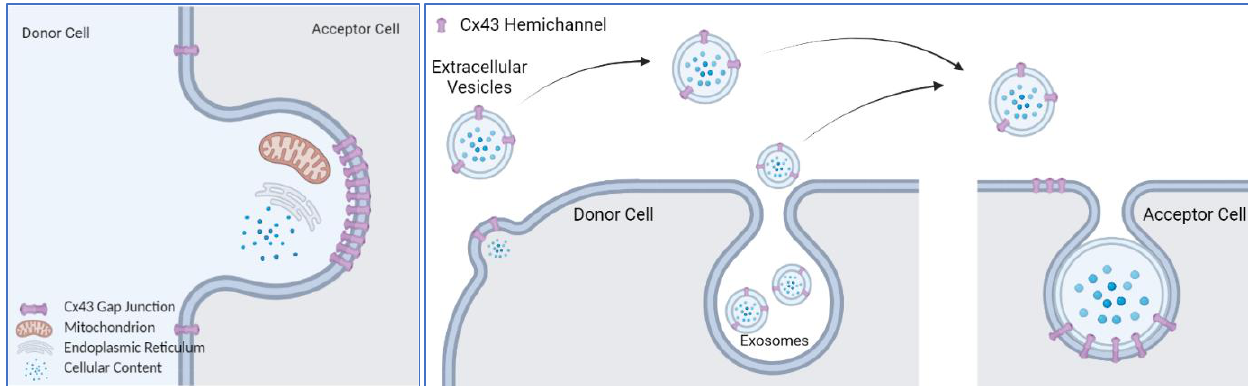
Figure 1. Membrane trafficking with Cx43. ( Left ): Internalization of cellular contents with Cx43 plaque. Cellular contents, including mitochondria, ER and ribosomes can be internalized with Cx43 plaque to form annular Cx43 vesicles. Mitochondria may escape from degradation and carry out function in acceptor cell. ( Right ): Cx43 gap junction mediates internalization of EVs and exosomes. Secreted EVs or exosomes contain functional Cx43 hemichannel on the membrane, that can dock with Cx43 hemichannel on the acceptor cell to make gap junctions and facilitate the internalization (shown here) or fusion of plasma membrane (not shown). Graphs were created with BioRender.com.